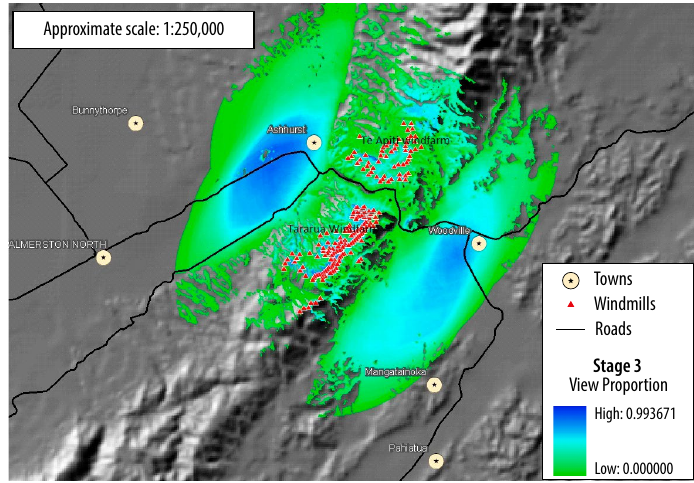
Fig. 2. Tararua and Te Apiti windfarm developments and viewshed